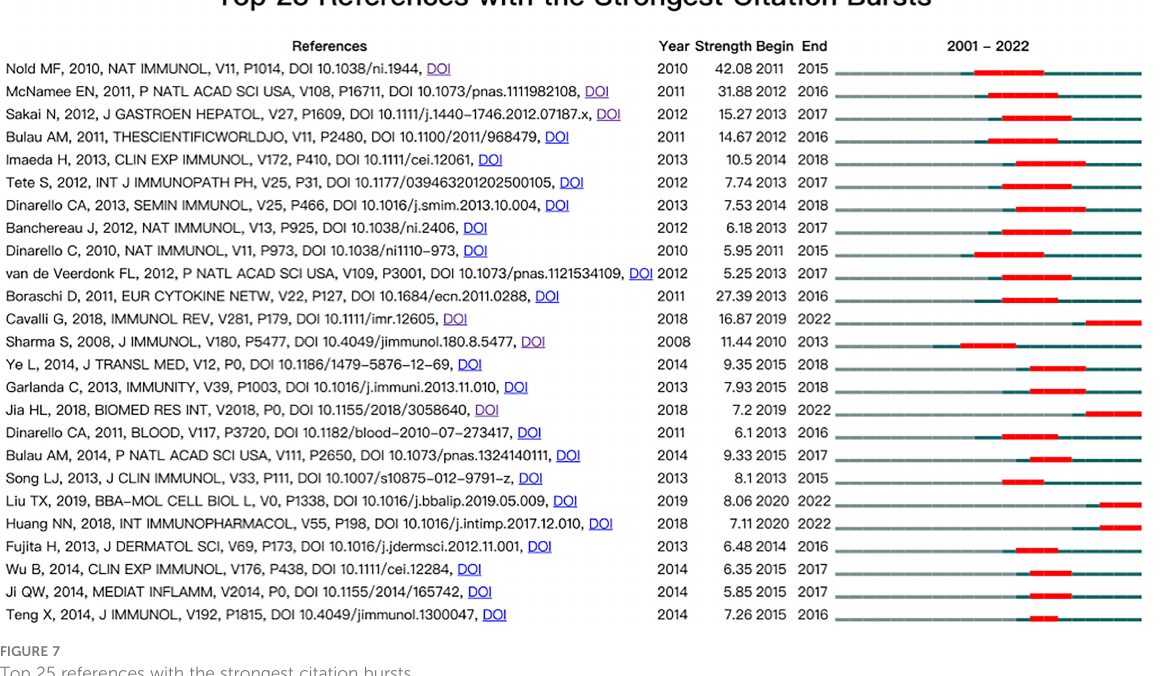
FIGURE 7 Top 25 references with the strongest citation